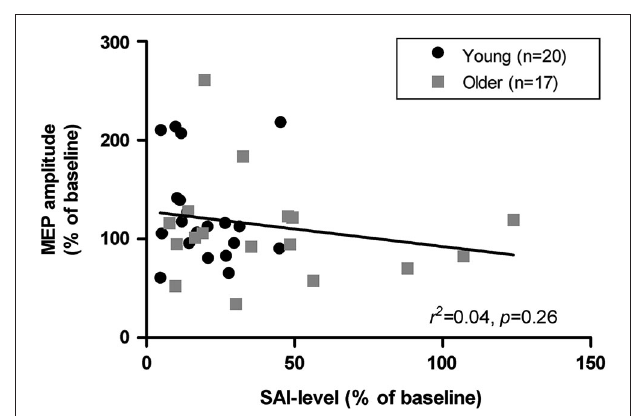
FIGURE 2 | Effect of iTBS at times 0, 5, 10, and 20 min following the procedure in young and older adults .